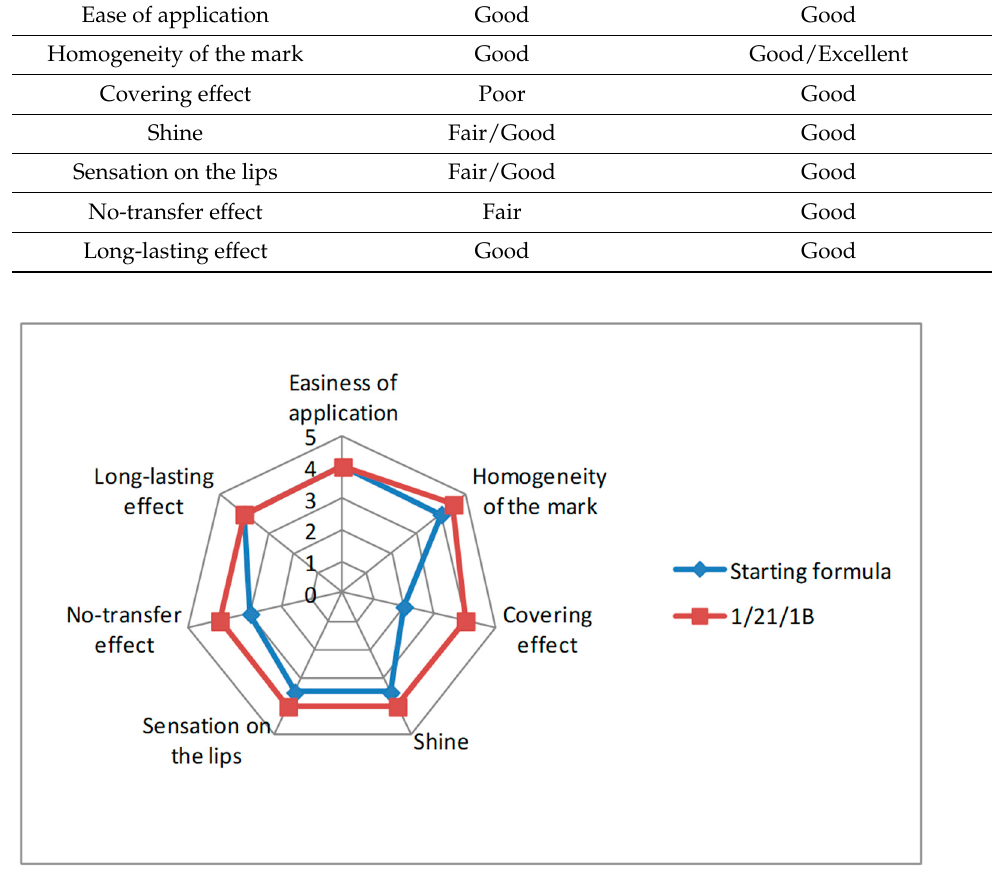
Figure 7. Initial formula vs. Ref. 1/21/1B (with 15% new oil). Table 14. Evaluation of the initial formula vs. Ref. 1/21/18 (final formula).